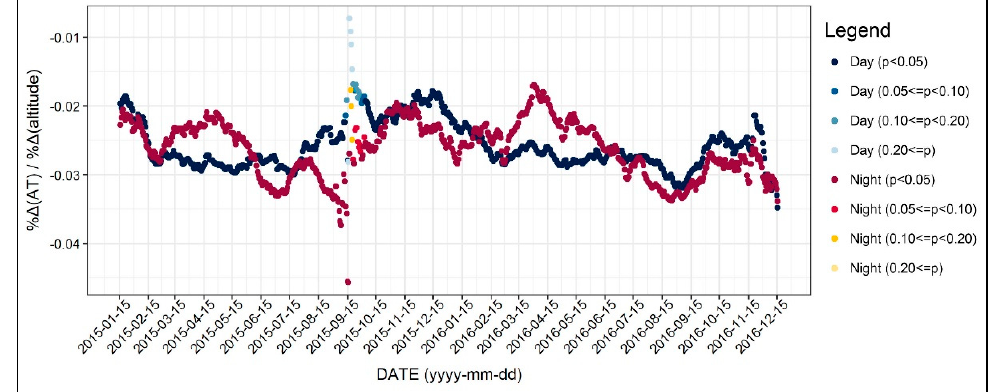
Figure 5. Changing patterns in the regression coefficients and their significances (Altutude of the automatic weather station (AWS)).